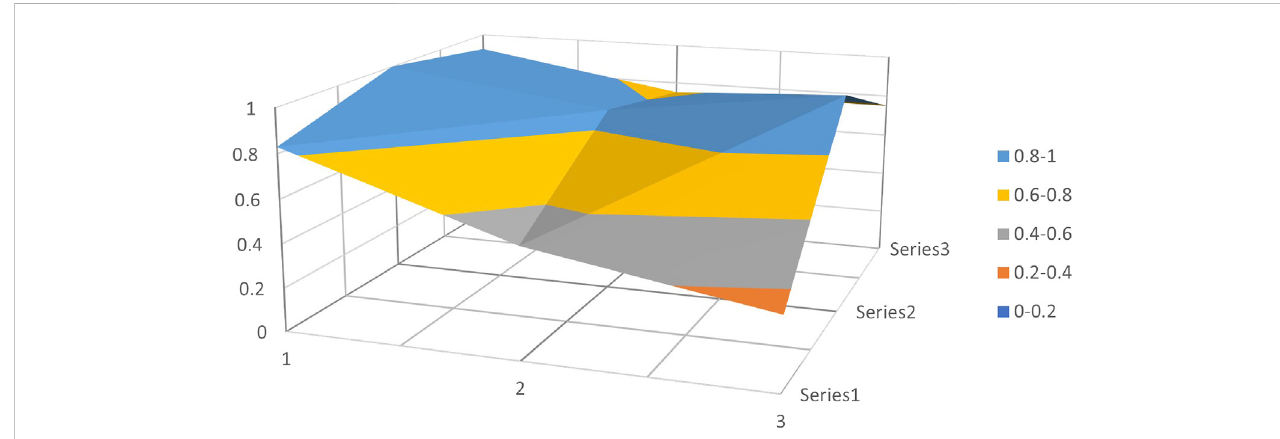
FIGURE 6 PMC surface of P 3 .